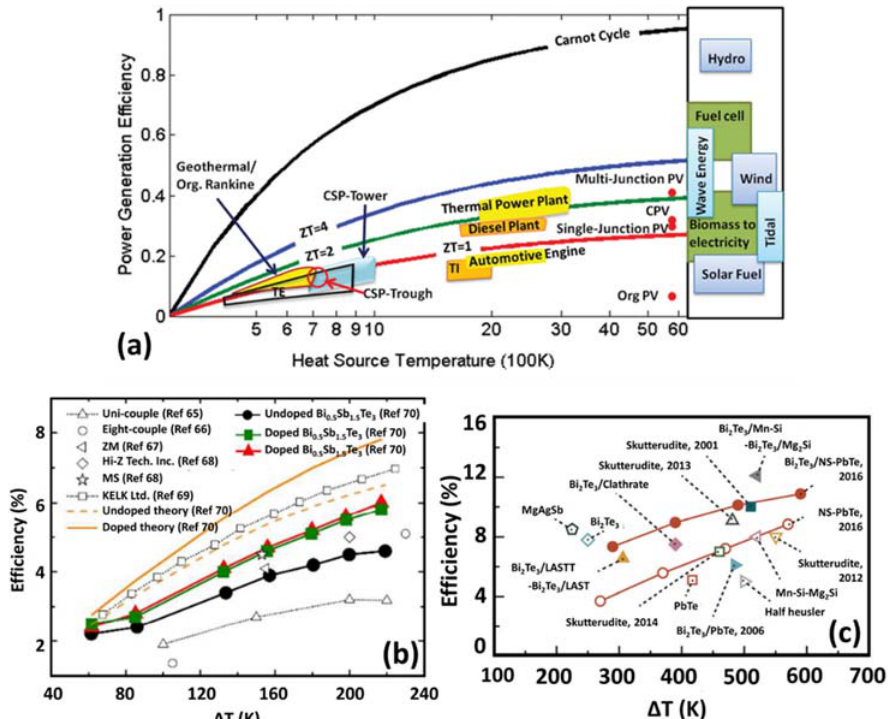
Figure 9. ( a ) Efficiency of thermoelectric generator against other thermal energy conversion technologies. (PV: photovoltaic, CSP: concentrated solar power, Org: Organic, TE: thermoelectric, and TI: thermionic devices). The cold side is considered to be at room temperature, adapted from [82], with permission from © 2012 Royal Society of Chemistry; ( b ) Efficiency reported for some of the state-of-art TEG modules suitable for low temperature thermal energy harvesting application, adapted from [88], with permission from © 2016 Royal Society of Chemistry; ( c ) Efficiency reported for some state-of-art TEG modules suitable for mid to high temperature applications, adapted from [89], with permission from © 2016 Royal Society of Chemistry.